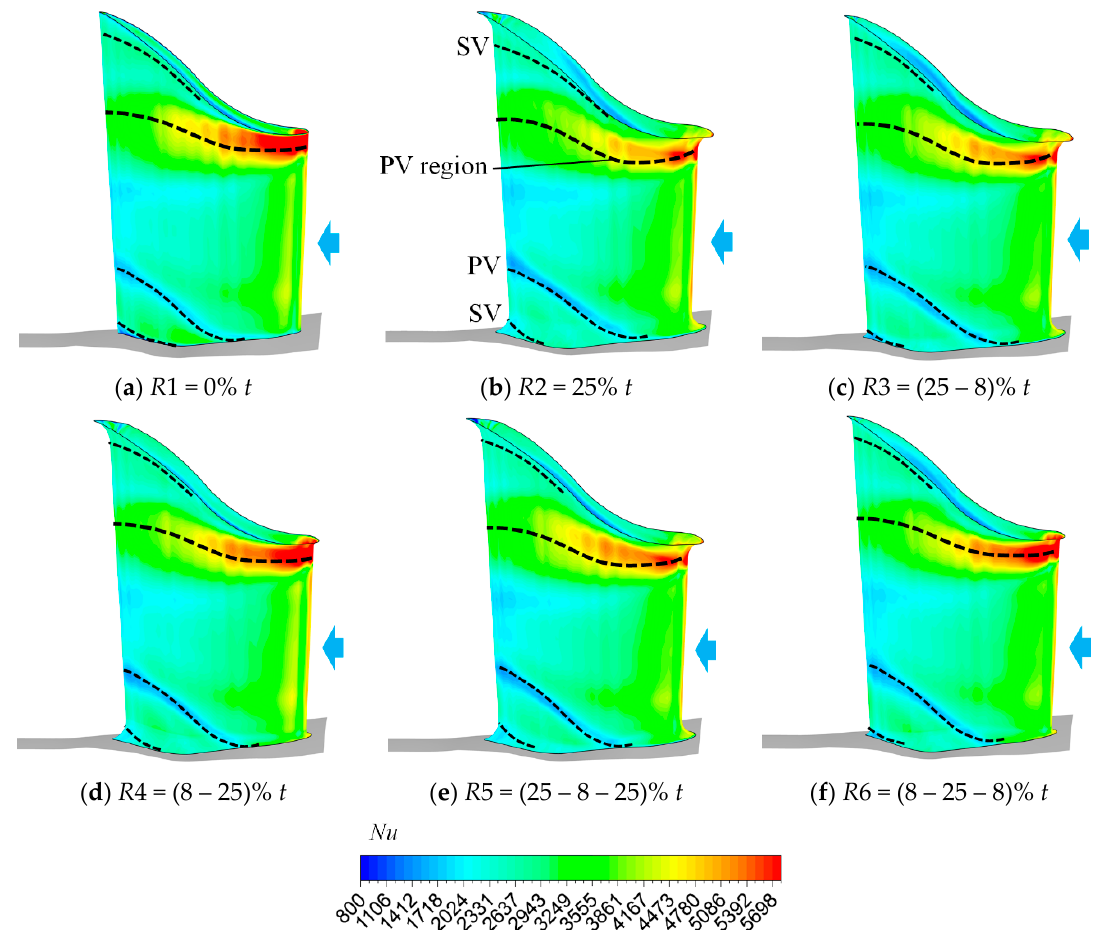
Figure 15. Nu distribution of the S2 blade suction surface.